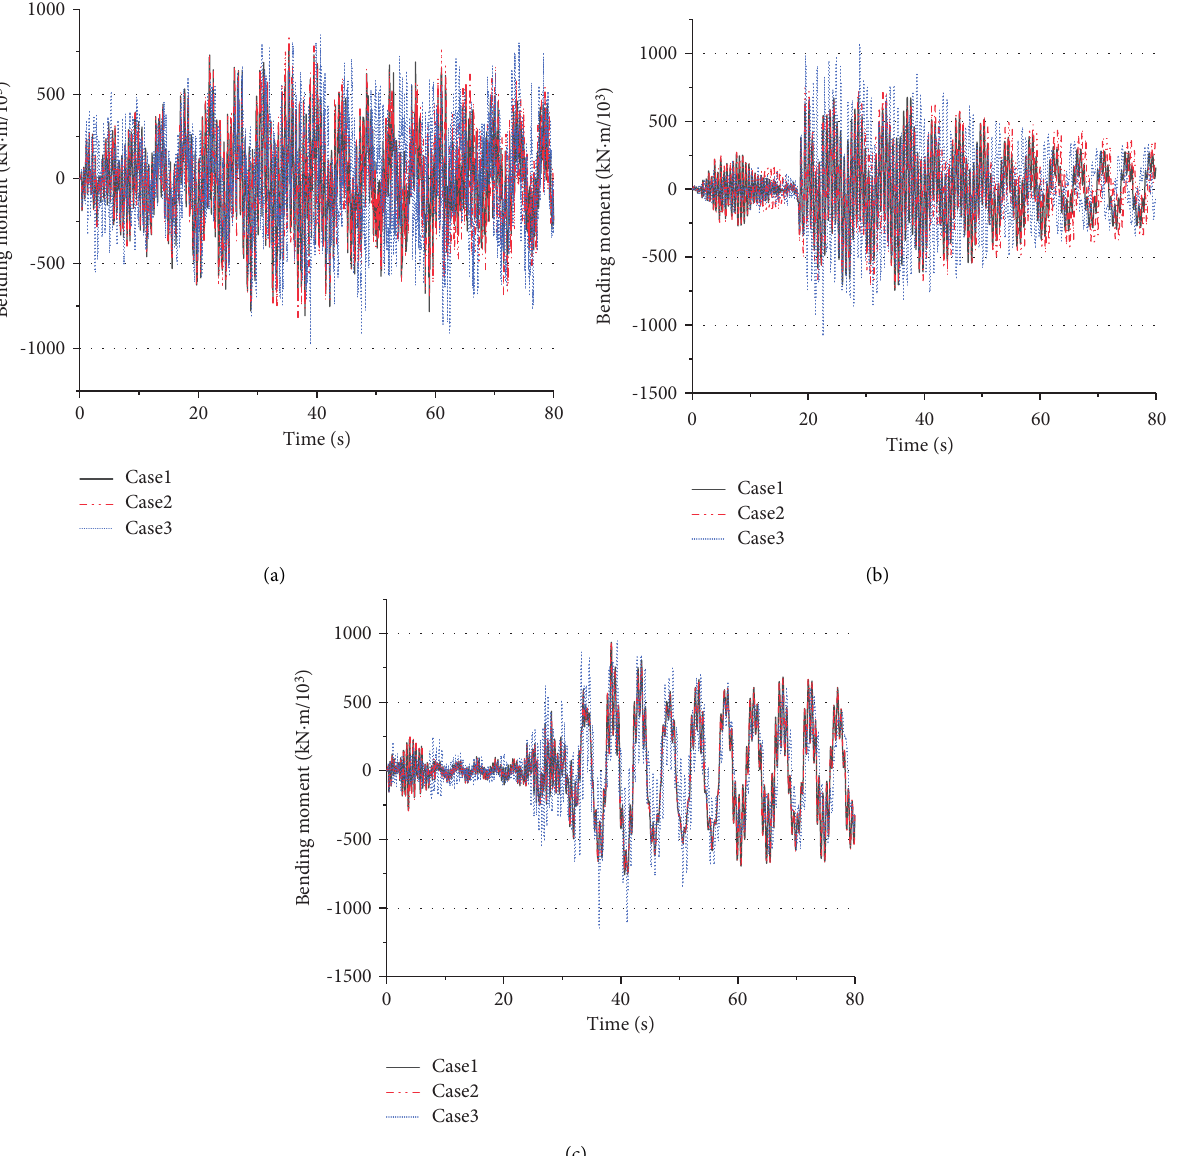
Figure 12: Bending moment time history of No. 3 pier in the three earthquakes. (a) 2011-03-11. (b) 2012-03-14. (c)